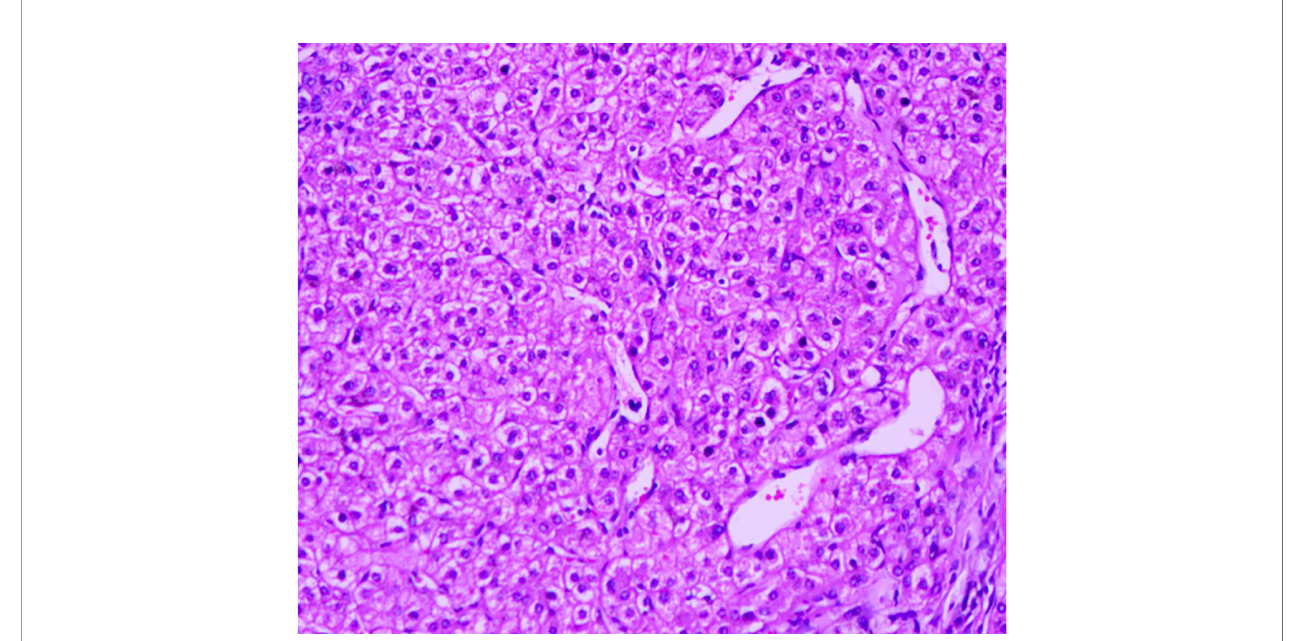
FIGURE 4 | Hematoxylin-eosin staining showed hepatocyte proliferation and vasodilation, and no atypical